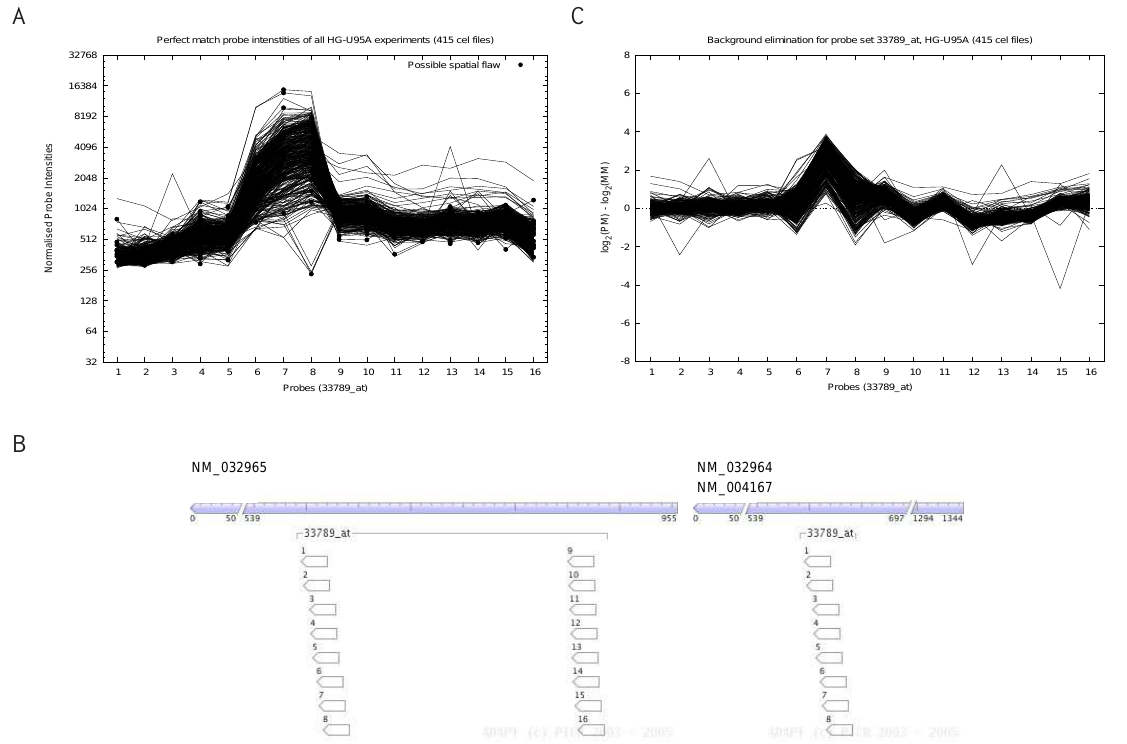
Figure 2: Probe intensities over all cel files for probe set 33789 at on the HG U95A array (A) Perfect match intensities (log scale) (B) ADAPT probe positions on the transcripts (C) Background elimination (log 2 (PM) - log 2